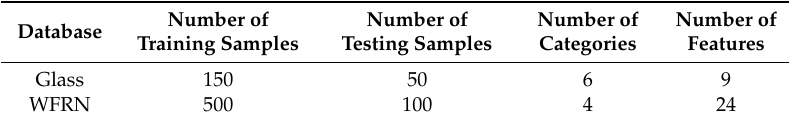
Table 1. Statistical information of the two data sets.